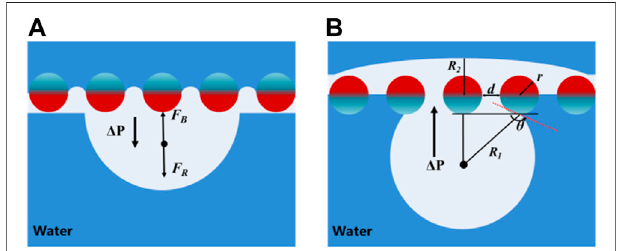
FIGURE 4 | Schematic diagram of underwater bubble unidirectional penetration on a single grid. (A) Air bubble cannot penetrate the superhydrophobic side but can sprawl. (B) Air bubble can penetrate the hydrophilic side and combine with the captured air layer on the superhydrophobic side